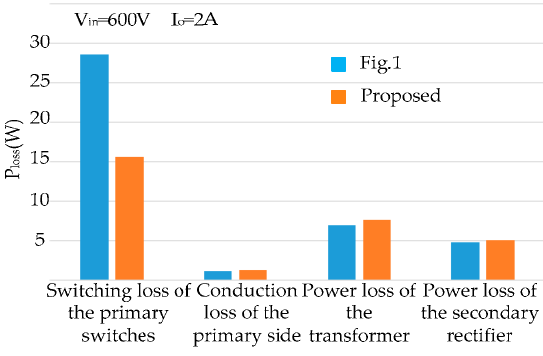
Figure 9. Power loss distribution.